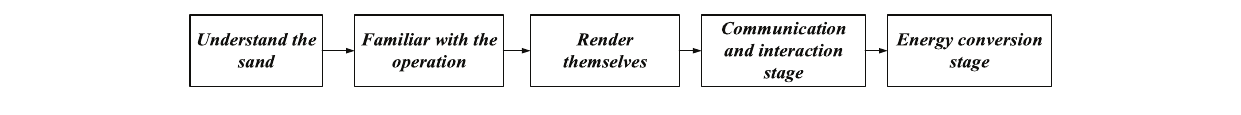
system. DVR system is based on the ordinary computer platform.